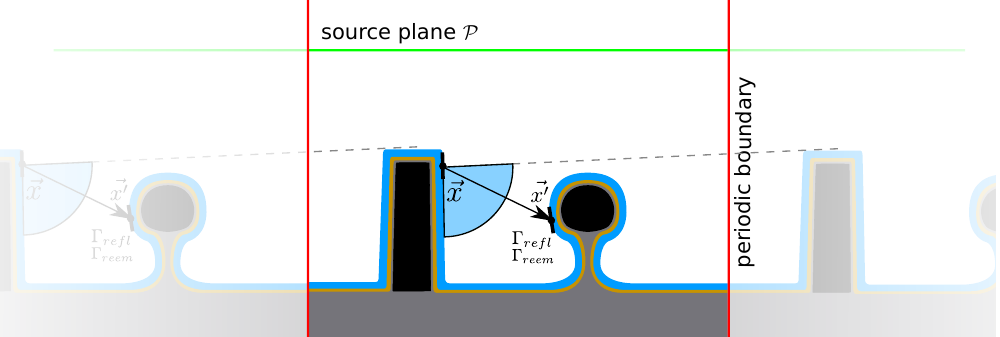
Figure 10. Calculation of reflected or reemitted fluxes using a bottom up technique with periodic simulation boundaries. The black arrow indicates the direction used to find the reflected and re-emitted flux incident on (cid:126) x from a particle source at (cid:126) x (cid:48) . The source distributions Γ refl and Γ reem define the flux emitted towards (cid:126) x . The total indirect flux at point (cid:126) x is found by summing the flux from all visible surface points, highlighted by the blue